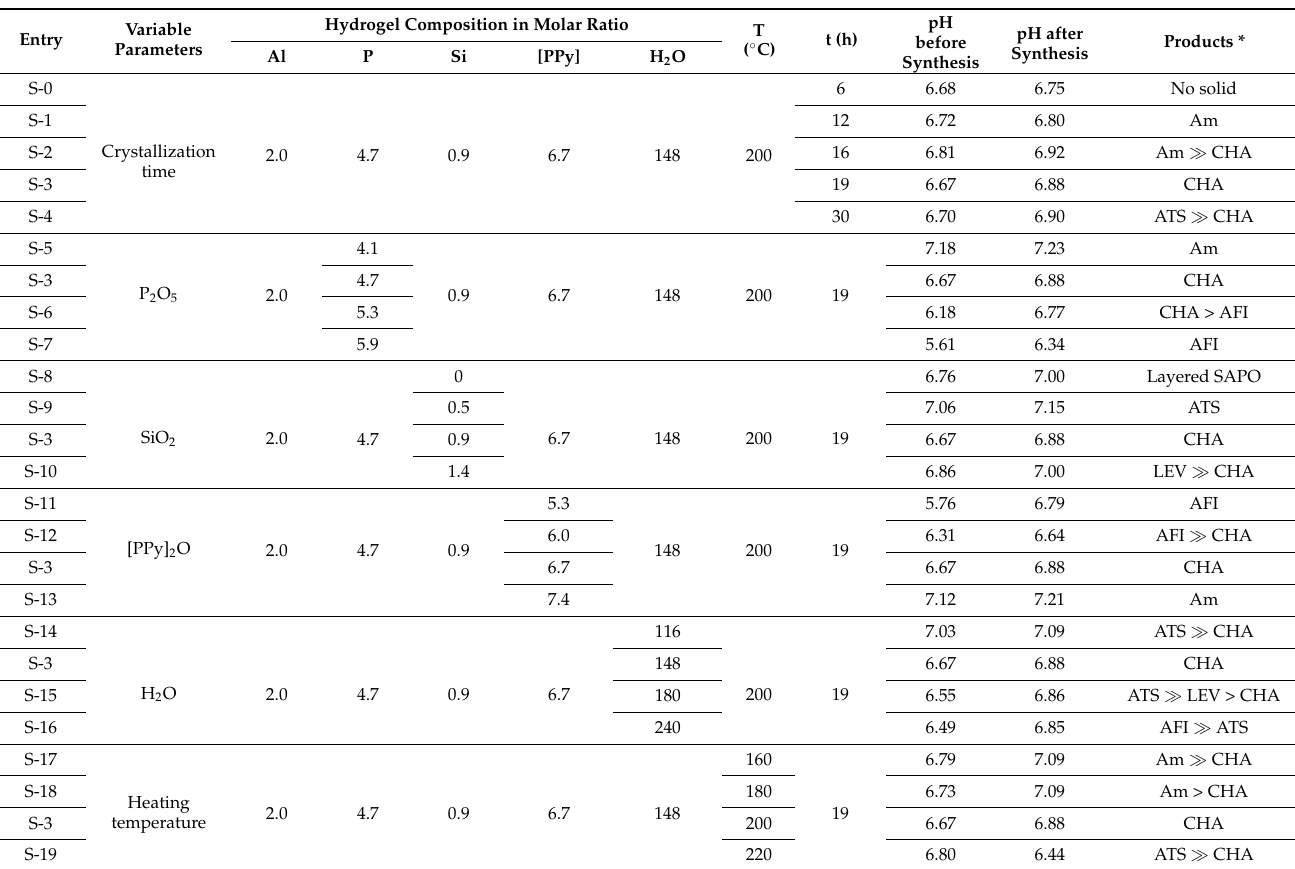
Table 2. The hydrothermal crystallization conditions of SAPO-34 by varying the synthesis variables and the phase products